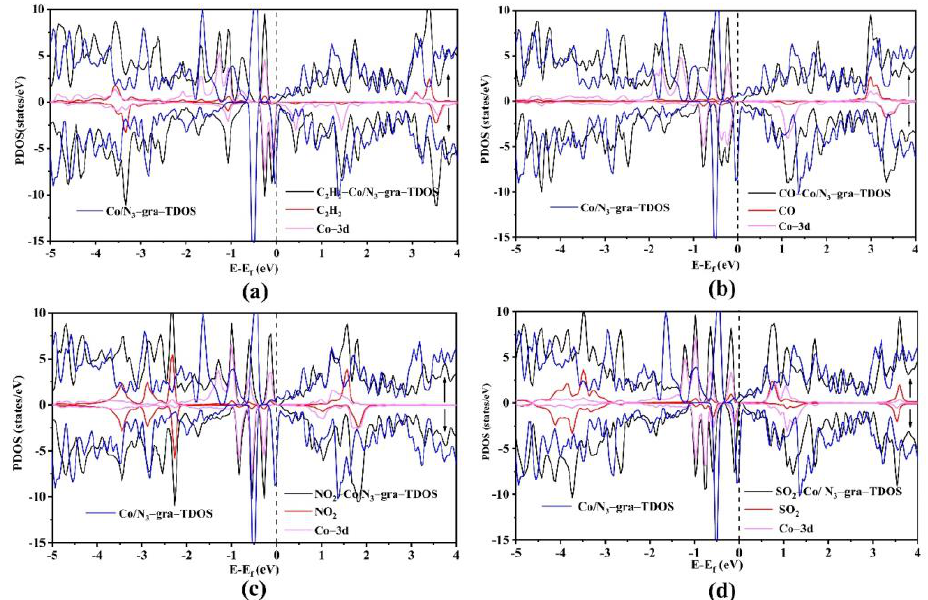
Figure 3. The density of states of gas molecules, including C 2 H 2 ( a ), CO ( b ), NO 2 ( c ), and SO 2 ( d ), adsorbed Co/N 3 – gra, with the up (down) spin denoted as ↑ ( ↓ ). The dotted line indicates the Fermi level.